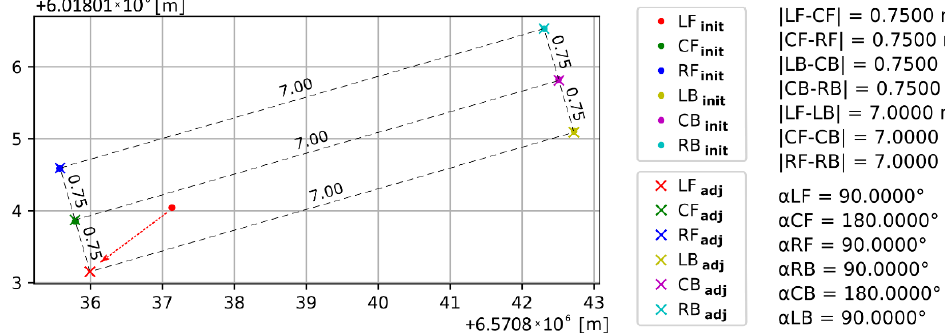
Figure 7. Example of the CLS adjustment result.